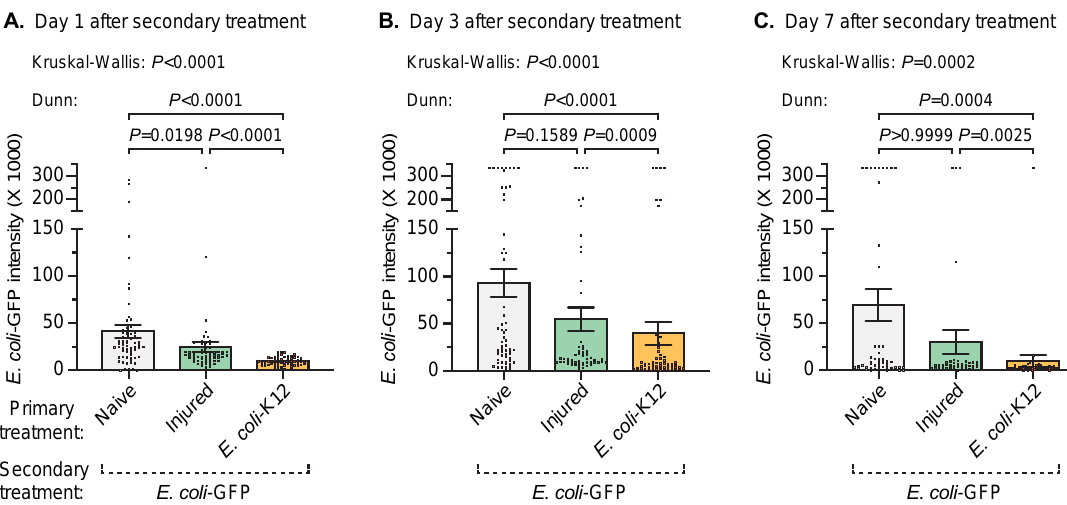
Figure 2. Infection intensity after secondary treatment. Five days after the primary treatment of naïve, injury, or infection with E. coli -K12, all the mosquitoes were infected with E. coli -GFP and the number of E. coli -GFP in their hemocoel was quantified 1 ( A ), 3 ( B ), or 7 ( C ) days later. Column heights mark the mean and whiskers denote the standard error of the mean (SEM). Circles mark the infection intensity of individual mosquitoes.